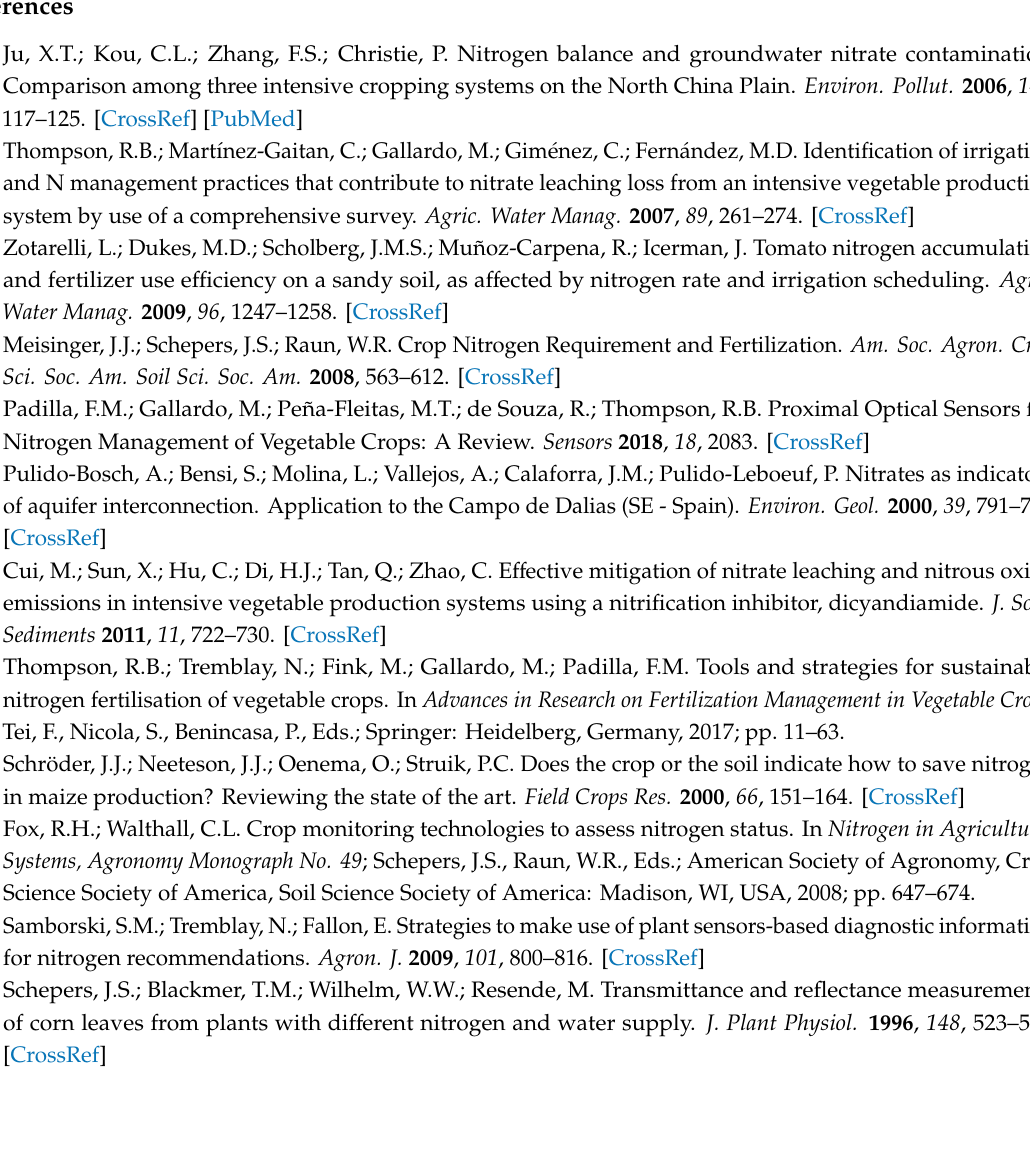
Table S6: P-values of the F-statistic analysis comparing the relationship between leaf N content and optical sensor measurements between the reduced regression for all three cultivars together and the regression of each cultivar of cucumber ( Cucumis sativus L.)